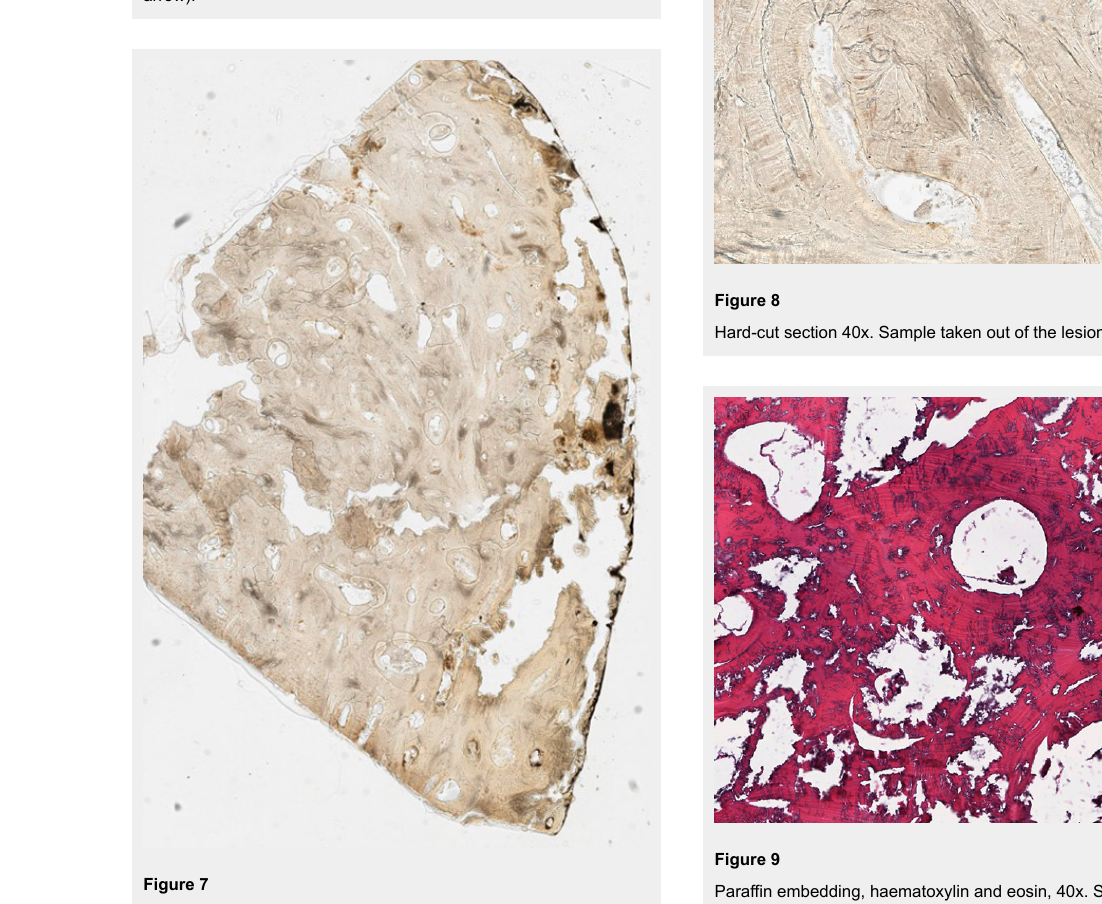
Hard-cut section 1.25x. Sample taken out of the lesion.